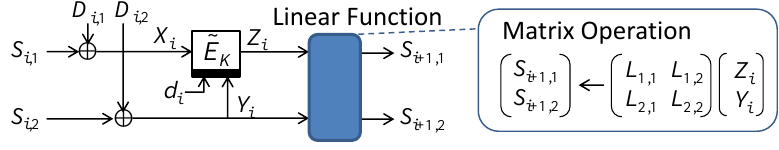
Figure 1: State Update Function SUF